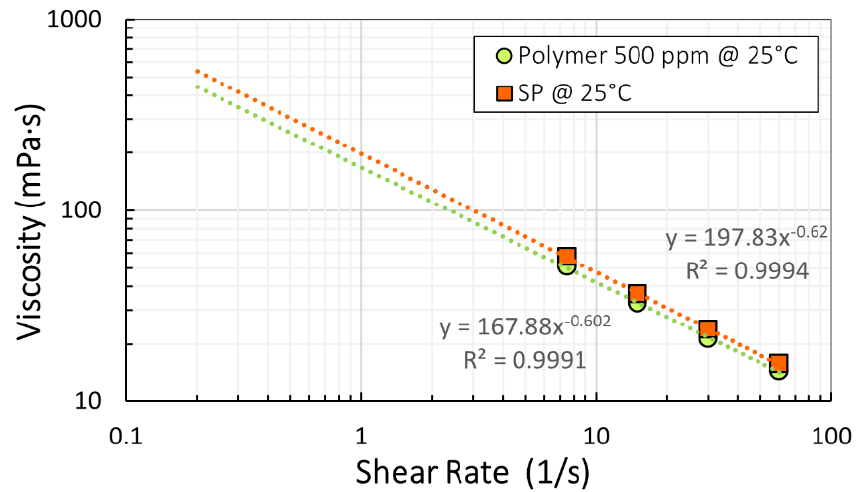
Figure 4. Viscosity versus shear rate for polymer and SP.